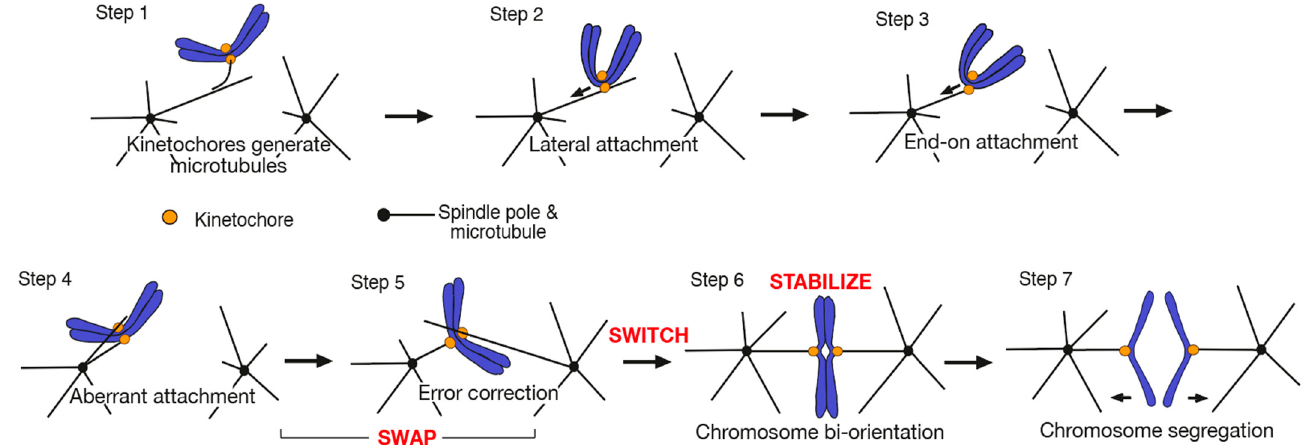
Figure 1. Diagram shows kinetochore–MT interactions during mitosis. Steps 1–6 show the processes, by which correct kinetochore–MT interactions are established, prior to chromosome segregation [4]. Step 7 shows chromosome segregation in anaphase. Each step is explained in the text. SWAP, SWITCH, and STABILIZE are the processes of error correction and the main topics of this review article.